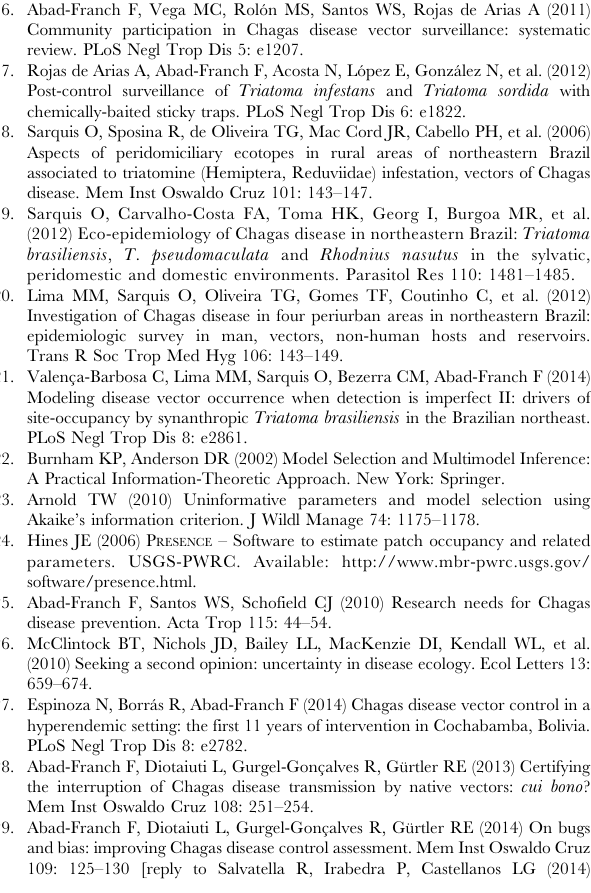
Table S2 Summary statistics for model-averaged vector-search sensitivity estimates: means, medians, quartiles and ranges of ecotope- and vector-search round-specific p 11 values; mean values for standard errors (SE), and upper/lower limits of the approximate 85% confidence intervals